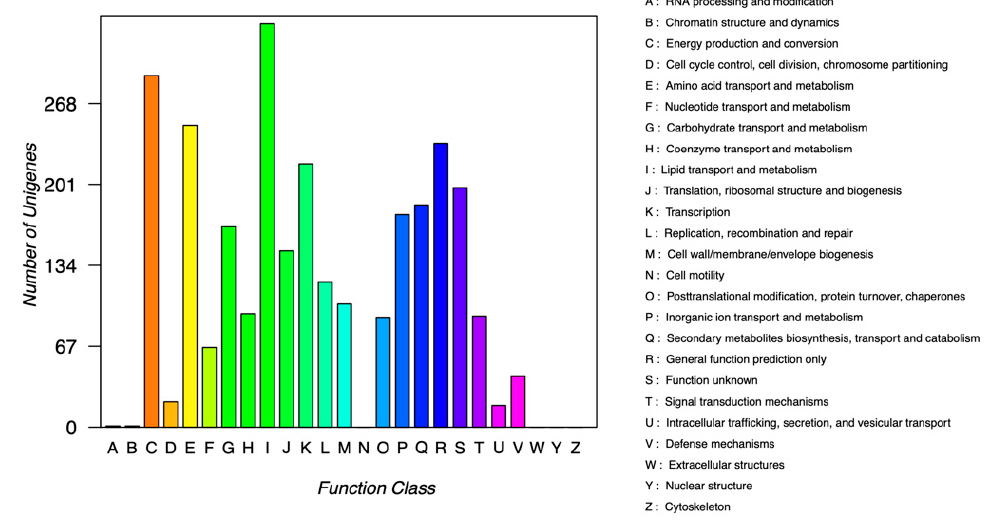
Figure 7. COG functional classification of strain